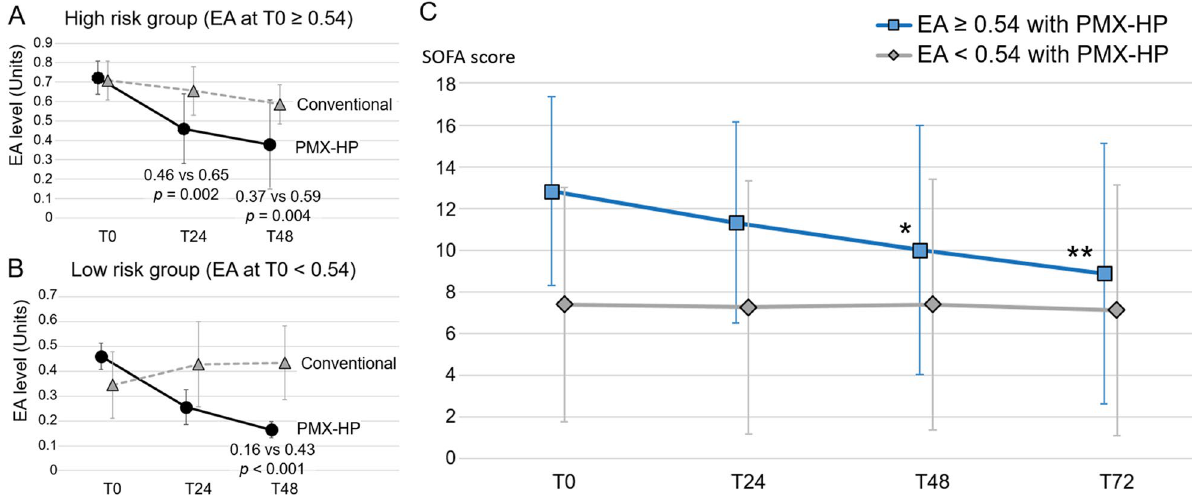
Figure 3. The comparison of changes in EA level with SD by period according to the conductance of PMX-HP or not. With PMX-HP treatment, difference of EA level showed significant time-by-group interactions in both high risk group ( A , F = 7.56, p = 0.003) and low risk group ( B , F = 10.58, p < 0.001). C, changes of SOFA scores with SD in patients who received PMX-HP treatment. The high risk group (blue, EA at T0 ≥ 0.54) showed continuous improvements in SOFA scores, whereas no improvements were revealed in the low risk group (gray, EA at T0 < 0.54). * p < 0.05 vs. baseline (T0); ** p < 0.01 vs. baseline (T0). EA endotoxin activity, PMX-HP